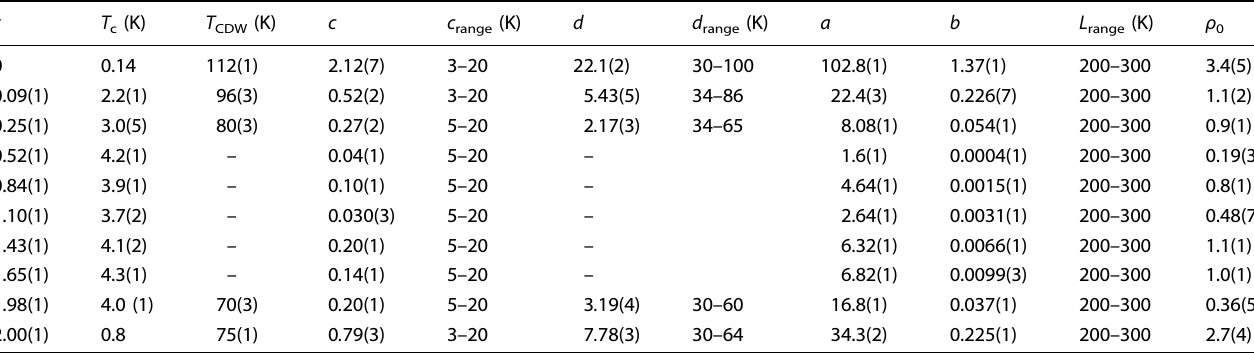
Table 2. Superconducting T c (de fi ned as 90% of normal state resistivity; Fig. 2d), charge density wave T CDW transition temperatures (de fi ned as peak in resistivity; Fig. 2b, c), and fi tting parameters of the CDW phase fl uctuations scattering model for resistivity (see